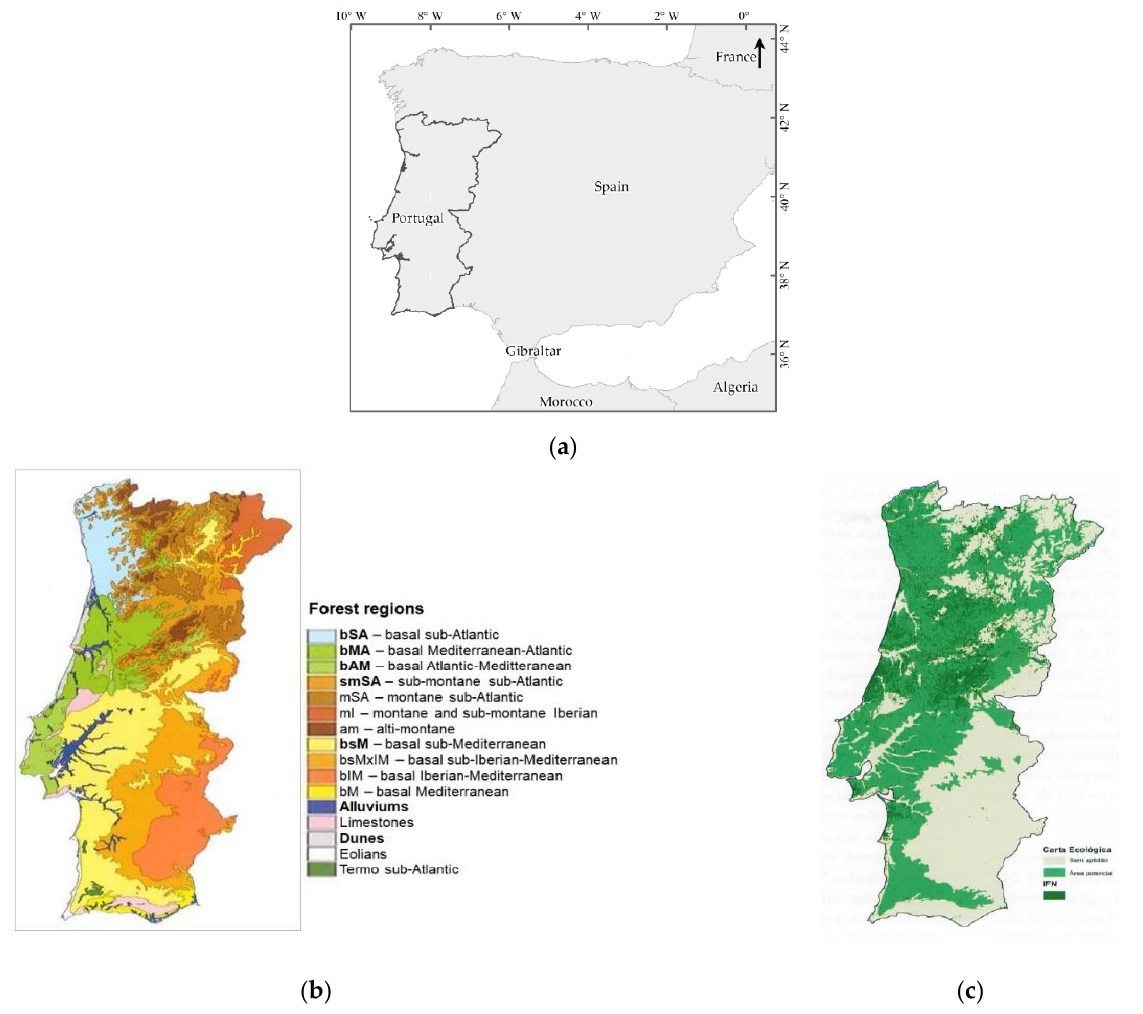
Figure 1. Study area: ( a ) Geographic location, ( b ) Forest regions for mainland Portugal [19], and ( c ) Maritime pine potential empirical distribution [25]. Legend: Forest regions of Maritime pine occur- rence (in bold) — bMA — basal (0 – 400 m) Mediterranean – Atlantic; bAM — basal (0 – 400 m) Atlantic – Mediterranean; bsM — basal (0 – 400 m) sub-Mediterranean; bSA — basa l (0 – 400 m) Sub-Atlantic; and smSA — sub-montane (400 – 700 m) sub-Atlantic.